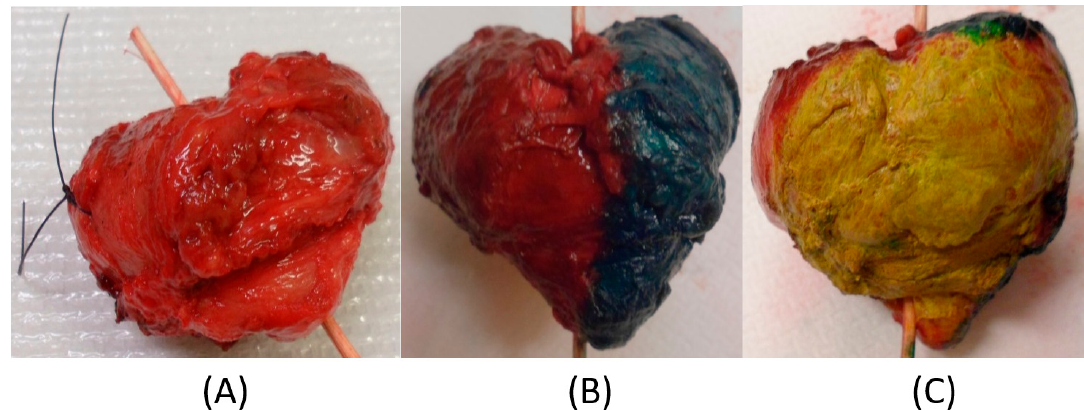
Figure 3. The resected radical prostatectomy specimen shortly after surgery from a 70-year-old man (Prostate 1 (P-1)). ( A ) Prostate gland without dye; ( B ) Dyed (green and red) on the (right and left) anterior side, apex is pointing down; ( C ) Dyed (yellow) on the dorsal side (the part facing the rectum).